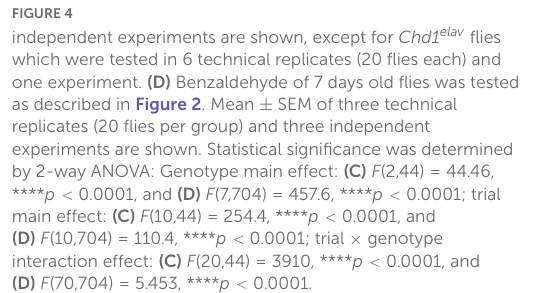
FIGURE4 independent experiments are shown, except for Chd1 elav flies which were tested in 6 technical replicates (20 flies each) and one experiment. (D) Benzaldehyde of 7 days old flies was tested as described in Figure 2 . Mean ± SEM of three technical replicates (20 flies per group) and three independent experiments are shown. Statistical significance was determined by 2-way ANOVA: Genotype main effect: (C) F (2,44) =